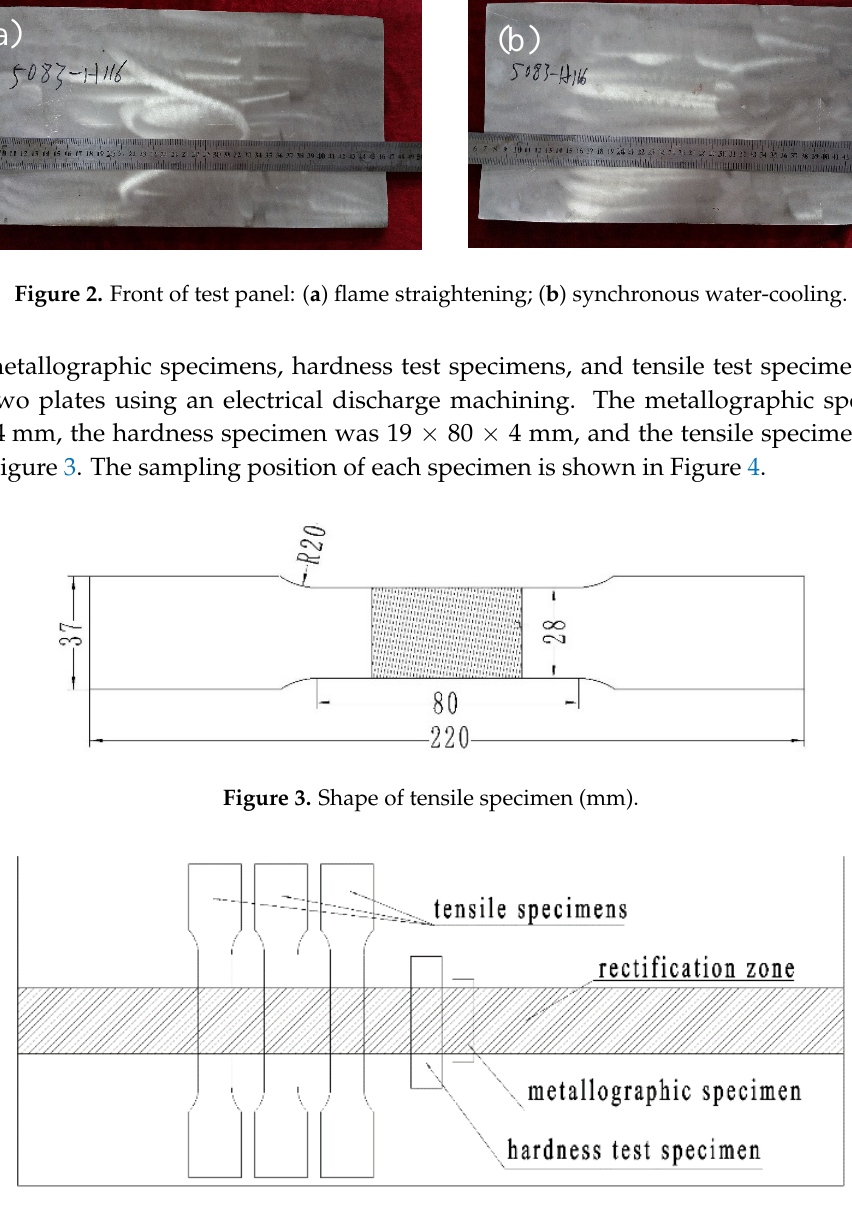
Figure 4. Sampling point of specimens.